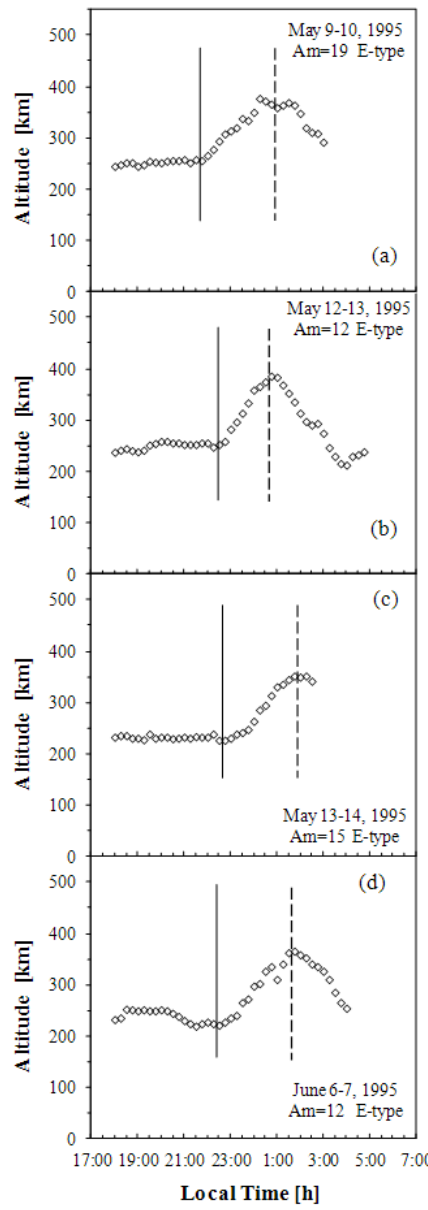
Figure 8. Night-to-night variability in the F-layer height as a func- tion of LT for four nights with E-type patterns. The solid and dashed lines indicate the successive positions of the start and the maximum of the peaks, respectively, from one night to the